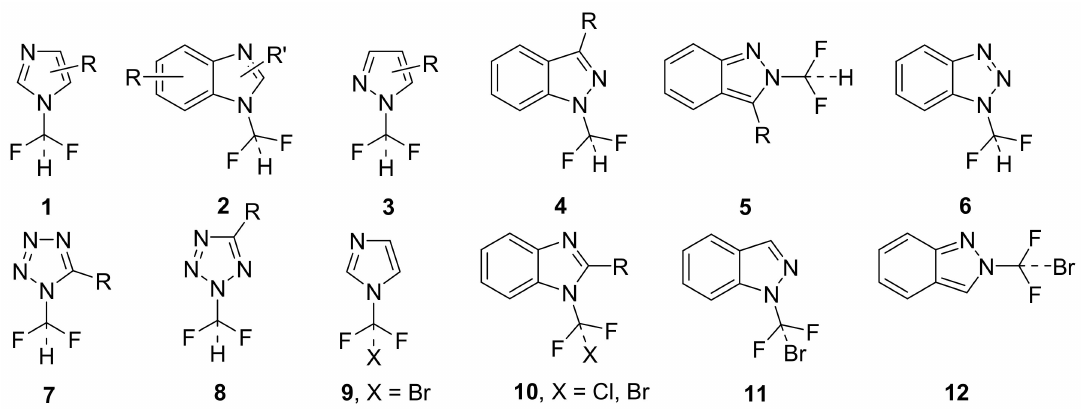
Figure 1. N -CHF 2 , N -CClF 2 , and N -CBrF 2 azoles and